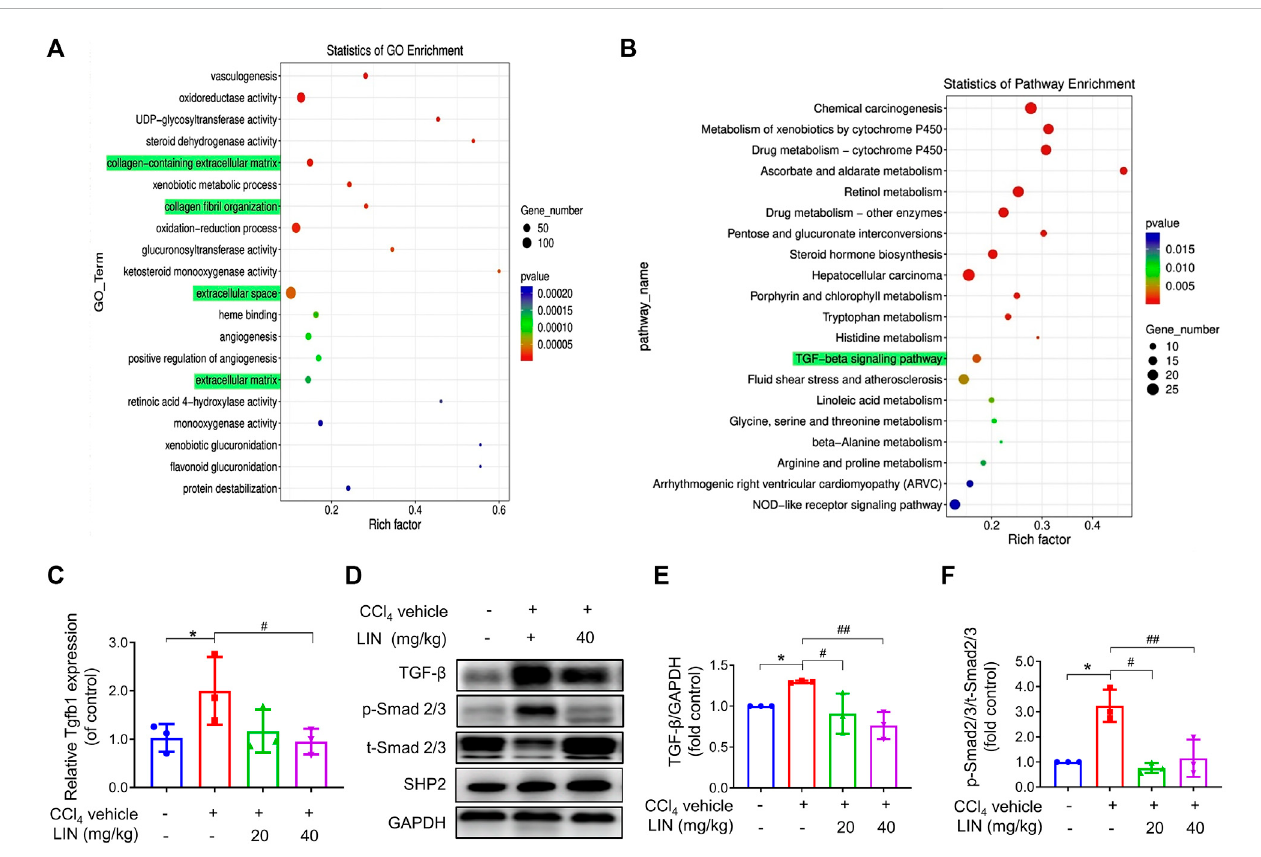
FIGURE 4 The anti- fi brosis effect of LIN is associated with inhibiting TGF- β /Smad signalling in vivo . RNA-seq showed 2163 differentially expressed genes with 716 genes upregulated, and 1447 genes downregulated between CCl 4 and LIN + CCl 4 groups, respectively ( n = 3). RNA-seq showed 6480 differentially transcripts with 3450 transcripts upregulated, and 3030 transcripts downregulated between CCl 4 and LIN + CCl 4 groups, respectively ( n = 3). (A) GO term enrichmentanalysisofdifferentiallyexpressedgenesrevealedthatLINagainstCCl 4 inducesliver fi brosispossiblybyregulatingcollagen − containingECM and collagen fi bril organization. (B) KEGG pathway analysis of differentially expressed genes showed that the potential mechanism of LIN regulating collagen − containing extracellular matrix was highly associated with the TGF- β signalling pathways involved. (C) Hepatic Tgfb1 (TGF- β ) mRNA expression ( n = 3). (D) TheexpressionofliverTGF- β ,p-Smad2/3,t-Smad2/3,andSHP2proteinswasdetectedbyWestern-blot,andGAPDHwasusedasaloadingcontrol. (E) The quantitative result of TGF- β . (F) The quantitative result of p-Smad2/3. The results represent three independent experiments. Data were expressed as means ± SEM. *p < 0.05 vs. control group; # p < 0.05, # # p < 0.01 vs. CCl 4